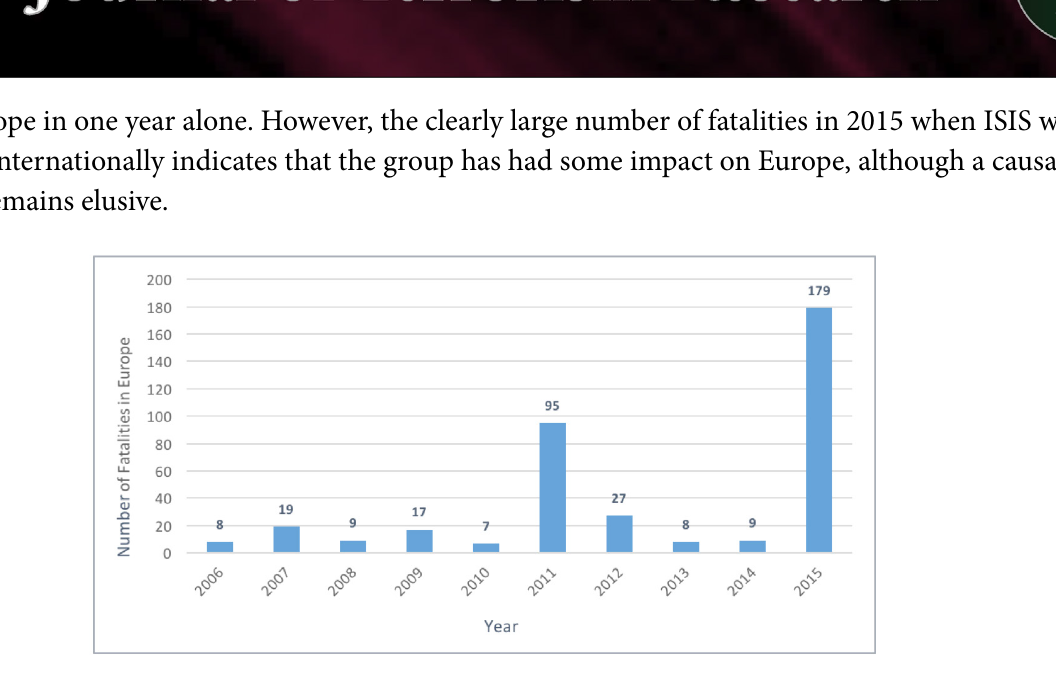
Figure 2. Number of fatalities arising from ISIS-related attacks in Europe between 2006 and 2015. (data taken from the Global Terrorism